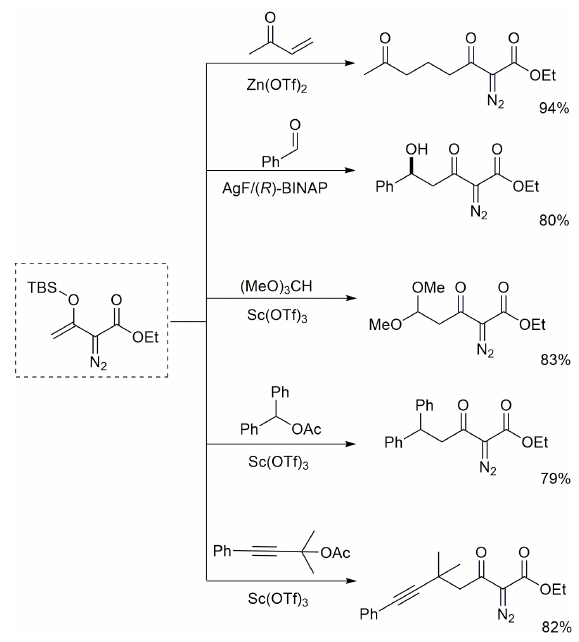
Figure 58 - Application of the silyl enol ethers of